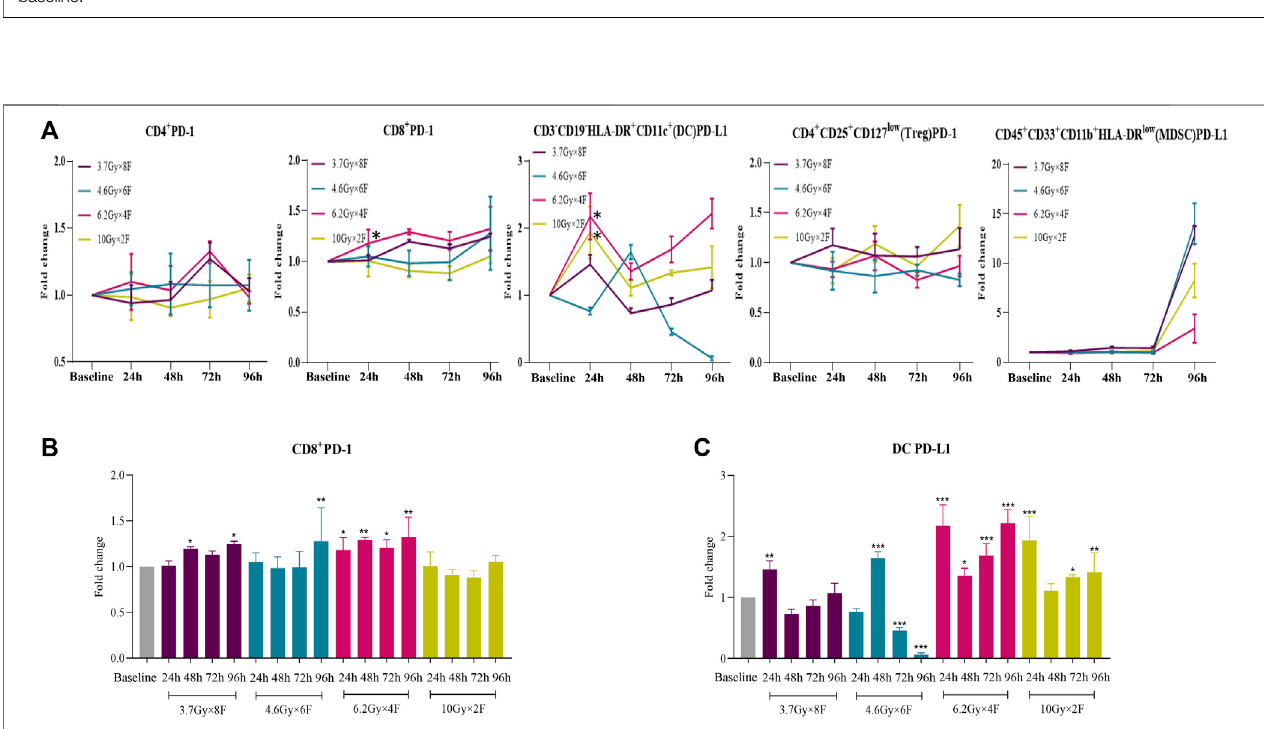
FIGURE6| Dynamic changesofPD-1 and PD-L1 expression after radiotherapy in peripheralblood ofNSCLCpatients. (A) TrendsofCD4 + PD-1, CD8 + PD-1, DC PD-L1, Treg PD-1, and MDSC PD-L1 after 4 different fractionation radiotherapies. * The dose in which trend was signi fi cant and the time at which difference began. (B) DiscrepancyofCD8 + PD-1atdifferenttimepointsafterradiotherapy,respectively. (C) DiscrepancyofDCPD-L1atdifferenttimepointsafterradiotherapy.* p ＜ 0.05,** p ＜ 0.01, *** p ＜ 0.001, compared with baseline.